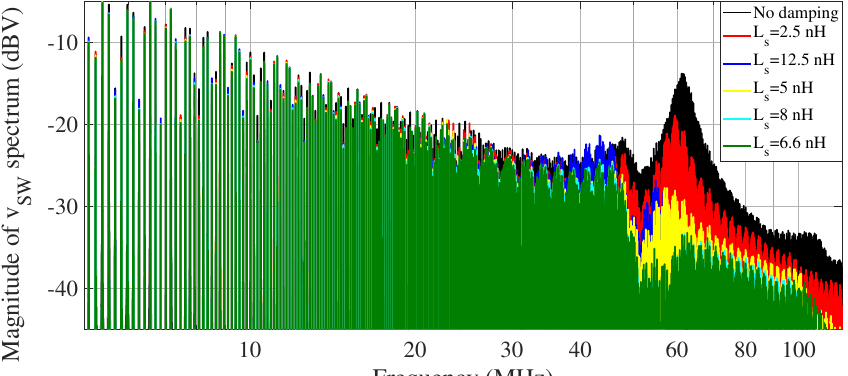
Figure 11. Measured time domain phase voltage v sw ( a ) and drain-source voltage ( v DS ) ( b ) at the T HS turn-on. The dashed lines were obtained in the oscillating case, the dotted ones with the low-side snubber inserted and the continuous ones with a 6.6 nH source inductance. The use of the source inductance allows one to reduce the over-voltage affecting the v sw at the turn-on.